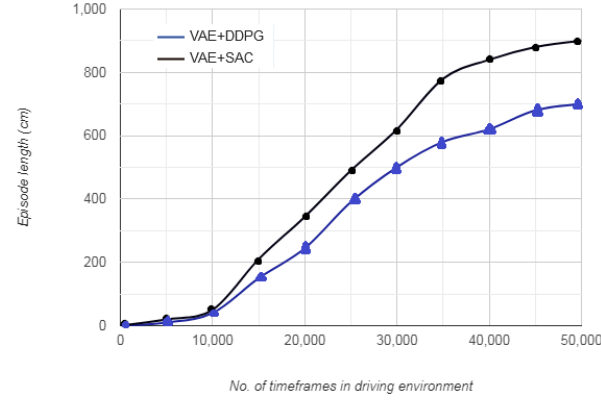
Figure 8. Episode length vs. no. of timeframes.